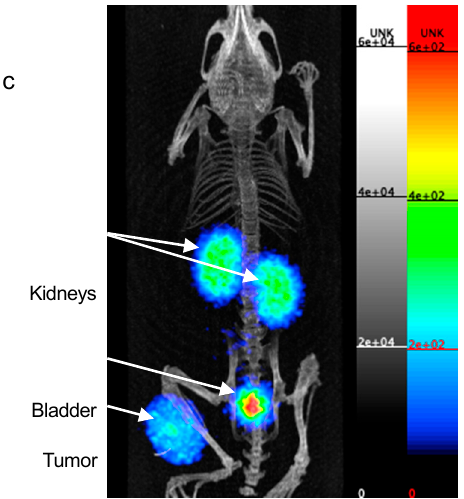
Figure 4. In vivo biodistribution at 1 h 20 p.i. ( a ) Preliminary experiment: Ex vivo biodistribution of site-specifically and randomly labeled [ 68 Ga]Ga-NOTA-(hPD-L1) Nbs in hPD-L1 POS tumors or hPD-L1 NEG tumors. (*** p < 0.001) ( b ) Comparison experiment: Ex vivo biodistribution profiles and tumor targeting of site-specifically and randomly labeled [ 68 Ga]Ga-NOTA-(hPD-L1) Nbs in hPD-L1 POS tumors. (NS, non-significant) ( c ) PET / CT image of a mice bearing hPD-L1 POS tumor 1 h 20 p.i. of [ 68 Ga]Ga-NOTA-(hPD-L1) Nb, obtained on the β -CUBE PET / CT system. Scale on the PET image is in kBq /